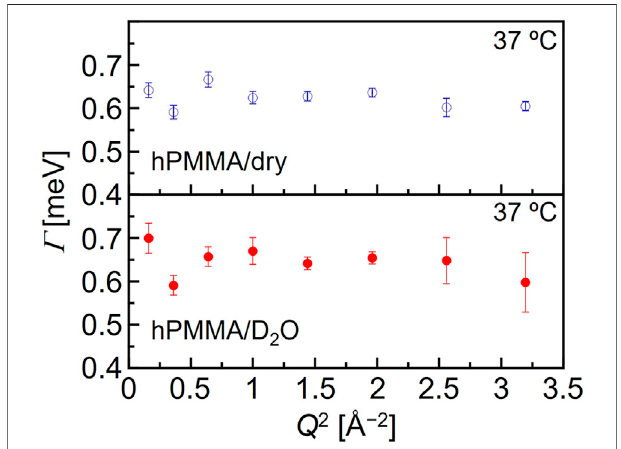
FIGURE 3 | Typical Q -dependence of the Lorentz function half width at half maximum ( Γ ) for the dry hPMMA and the hydrated hPMMA at 37 ° C.